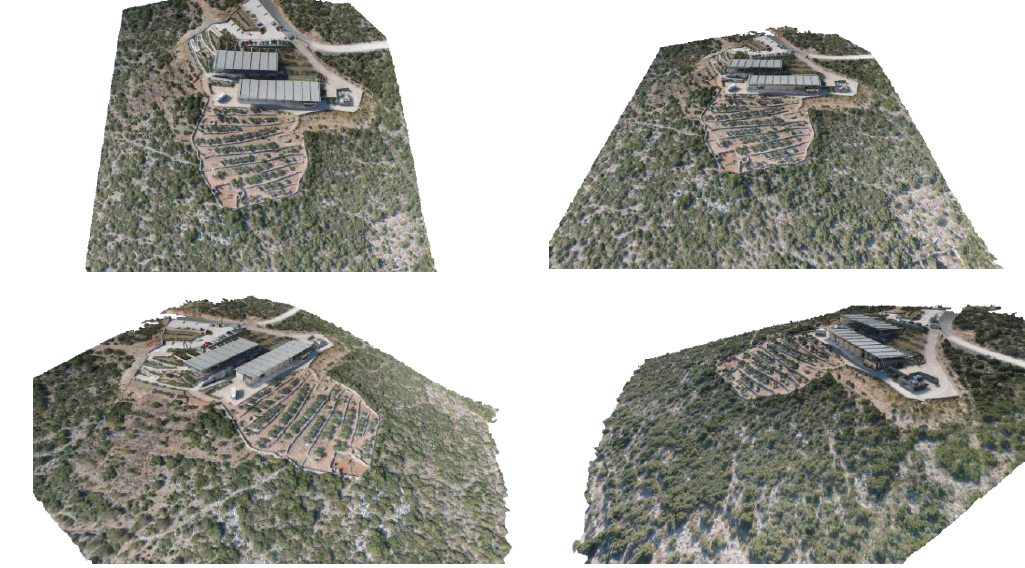
Figure 8. Rural building and mastic garden (RGB views).